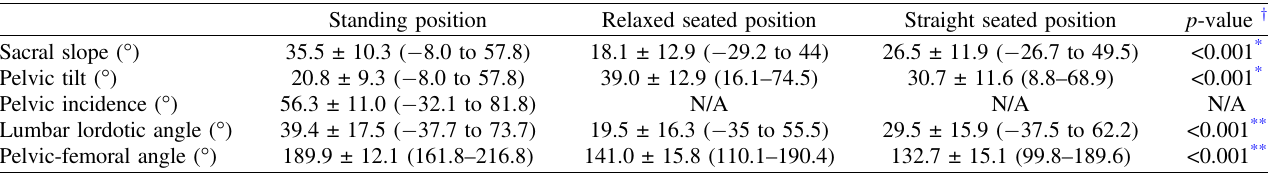
Table 1. Spinopelvic sagittal alignment parameters in each position and comparison of each parameter between the relaxed and straight seated positions.